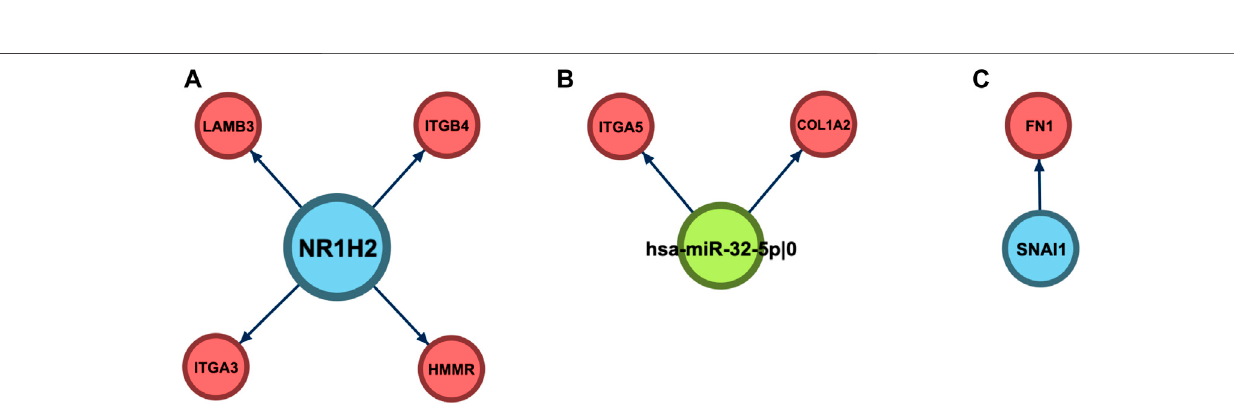
Frontiers in Genetics |